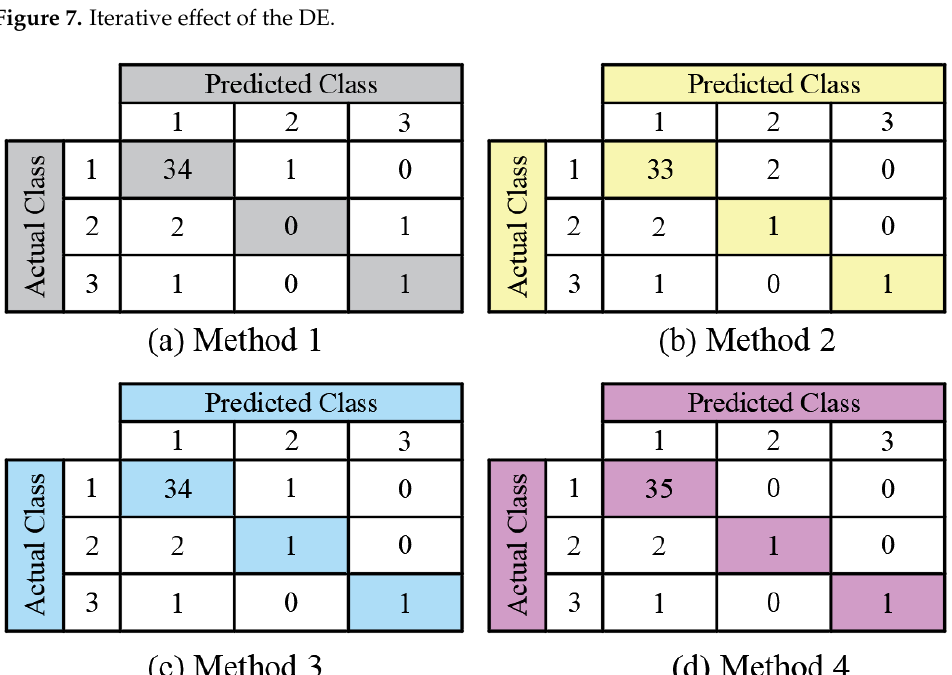
Figure 8. Confusion matrices for the test sets.